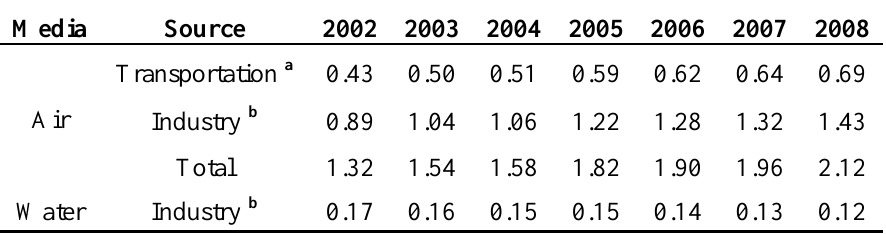
Table 1. Estimated emission rates of BaP (2002–2008,